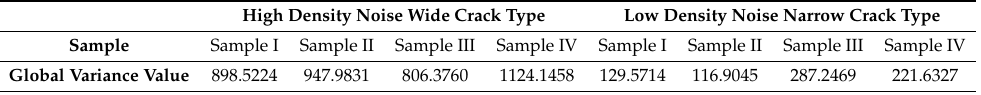
Figure 3. Comparison of the original binarization effect. ( a ) indicates the effect for wide crack type, ( b ) indicates which for narrow crack type. Table 1. Global Variance Calculation